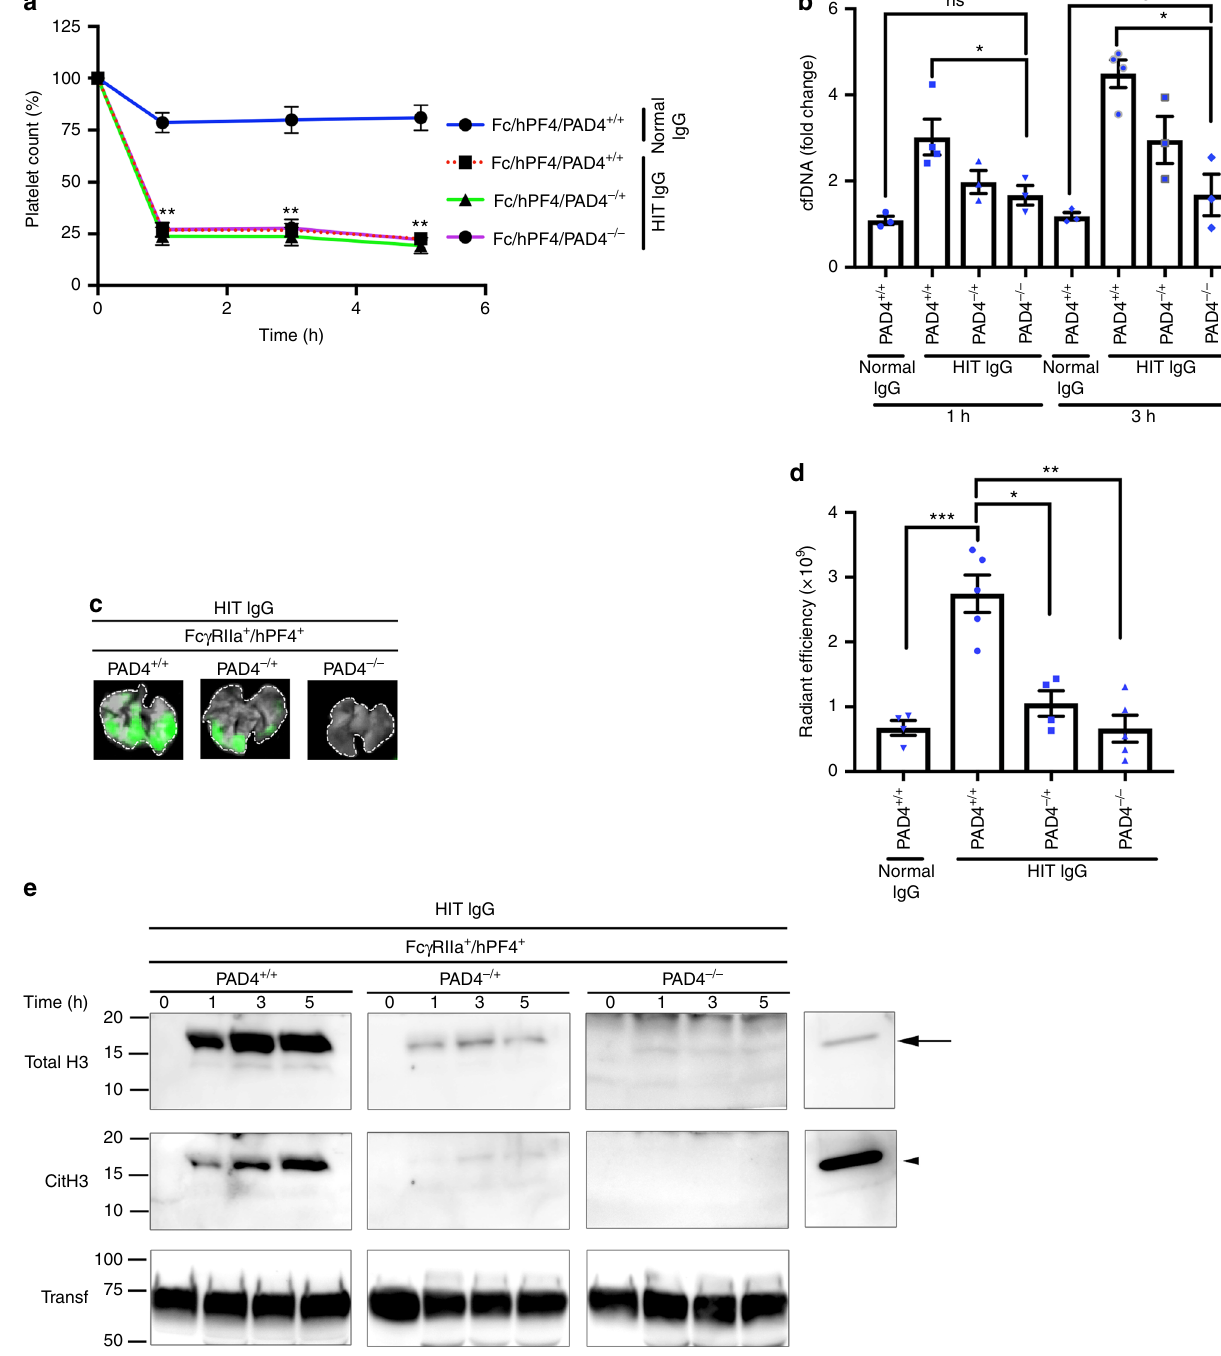
Fig. 6 PAD4-de fi cient mice are protected from HIT IgG-induced thrombosis. a Fc γ RIIa + / hPF4 + double transgenic mice wild-type, heterozygous or knockout for PAD4 ( PAD4 + / + , PAD4 − / + or PAD4 − / − , respectively) were injected intravenously with normal IgG or HIT IgG. Heparin was injected in all cases intraperitoneally at 1 U/g. Platelets were counted at the time points indicated. The percentage of platelets was calculated relative to basal levels. Data are expressed as means ± s.e.m. ( n = 5). b cfDNA in plasma of Fc γ RIIa + /hPF4 + /PAD4 + / + ( n = 4), Fc γ RIIa + /hPF4 + /PAD4 -/ + ( n = 3) and Fc γ RIIa + /hPF4 + / PAD4 − / − ( n = 3) mice 1 h and 3 h after normal IgG ( n = 3) or HIT IgG plus heparin treatment. Mean ± s.e.m. c Representative images of mouse lungs for Fc γ RIIa + /hPF4 + /PAD4 + / + , Fc γ RIIa + /hPF4 + /PAD4 − / + and Fc γ RIIa + /hPF4 + /PAD4 − / − imaged as described in Fig. 3b. d Graphical representation of fold changes in fl uorescence intensity (radiant ef fi ciency) in lungs from Fc γ RIIa + /hPF4 + /PAD4 + / + ( n = 5) , Fc γ RIIa + /hPF4 + /PAD4 − / + ( n = 4) and Fc γ RIIa + / hPF4 + /PAD4 − / − ( n = 5) mice described in ( a ). Mean ± s.e.m. e Western blots (representative of four independent experiments) of CitH3 in plasma of the transgenic mice described in ( a ) probed with anti-total H3 and anti-CitH3 antibody at the indicated times after treatment with HIT IgG plus heparin. Transferrin was used as a loading control. Arrow denotes total H3. Arrowhead indicates CitH3. Transf, transferrin. Kruskal – Wallis test and P -values adjusted by Holm ’ s Stepdown Bonferroni procedure relative normal IgG were used for statistical analyses. * P < 0.05; ** P < 0.01; *** P < 0.001. ns not signi fi cant. Source data for ( a , b , d , e ) are provided as a Source Data fi